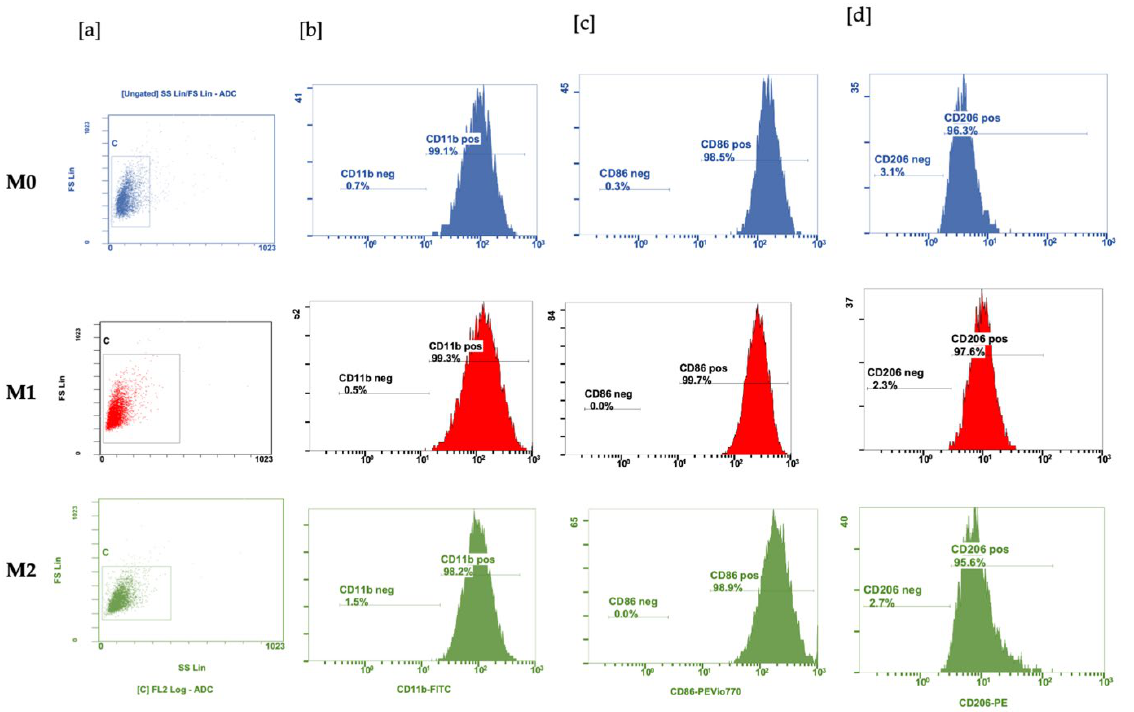
Figure 2. Polarization of BMDM: Macrophages were generated by incubating myeloid progenitor cells with M-CSF for seven days, then activated for 24 h with 100 ng/mL LPS (M1) or 20 ng/mL IL-4 plus 20 ng/mL IL-10 (M2). ( a ) Forward- and side-scatter profiles of macrophages and flow cytometric characterization of CD11b; ( b ) differential expression of cell surface markers CD86 ( c ) and CD206 ( d ) in M0 (blue panel), M1 (red panel) and M2 (green panel) macrophages. Based on median fluorescence intensity (MFI) n = 3, shown in Figure S1B (see Supplementary Materials), the MFI CD 86 was highest in M1 as compared with M0 and M2, whilst the MFI of CD206 was highest in M2-polarized macrophages. M0 macrophages expressed intermediate amounts of surface markers. The histogram represents the results obtained from one run.